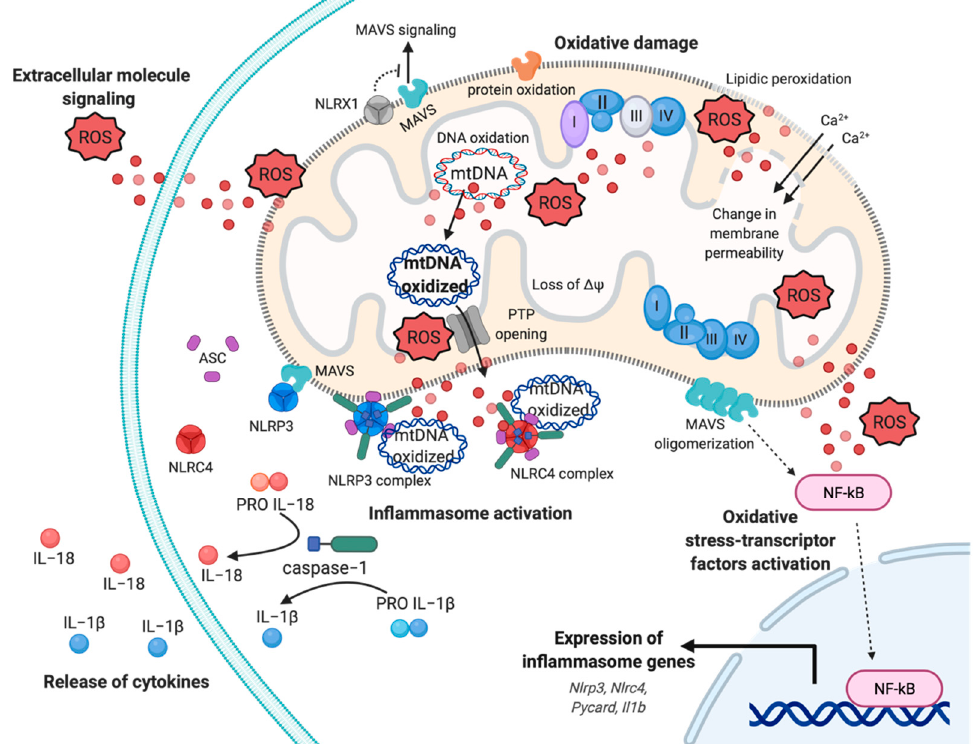
Figure 2. Mitochondrial ROS-induced inflammatory response. Representation of multifaceted aspects of mitochondrial ROS in inflammation. Increased mtROS cause oxidative damage to mitochondrial membrane, with events of lipidic peroxidation and changes in membrane permeability, molecules, proteins, and mtDNA, which contribute to mitochondrial dysfunction and exacerbation of mtROS production. The dissemination of mtROS actives the redox-sensitive transcription factor NF-kB, inducing the expression of inflammasome genes, such as Nlrp3, Nlrc4, and Il1b genes. In turn, the mtROS and mtDNA promote the cytokines release mediating the inflammasome NLRP3 and NLRC4 complex activation, through the recruitment of pro-caspase − 1 and the processing of pro-IL − 1 and pro-IL − 18. Finally, mtROS are reversed to extracellular milieu to sustain and exacerbate the inflammatory responses, affecting proximal cells and conditioning the inflammatory microenvironment. Abbreviations: Reactive oxygen species, ROS; Interleukin − 18, IL − 18; Interleukin − 1, IL − 1; NLR Family CARD Domain Containing 4, NLRC4; ASC; NLR Family Pyrin Domain Containing 3, NLRP3; Mitochondrial antiviral-signaling protein, MAVS; mitochondrial deoxyribonucleic acid, mtDNA; NLR Family member X1 precursor, NLRX1; Calcium, Ca 2+ ; Nuclear factor kappa-light-chain-enhancer of activated B cells, NF-kB; Mitochondrial membrane potential, Δ Ψ . This figure has been created with “BioRender.com.”.